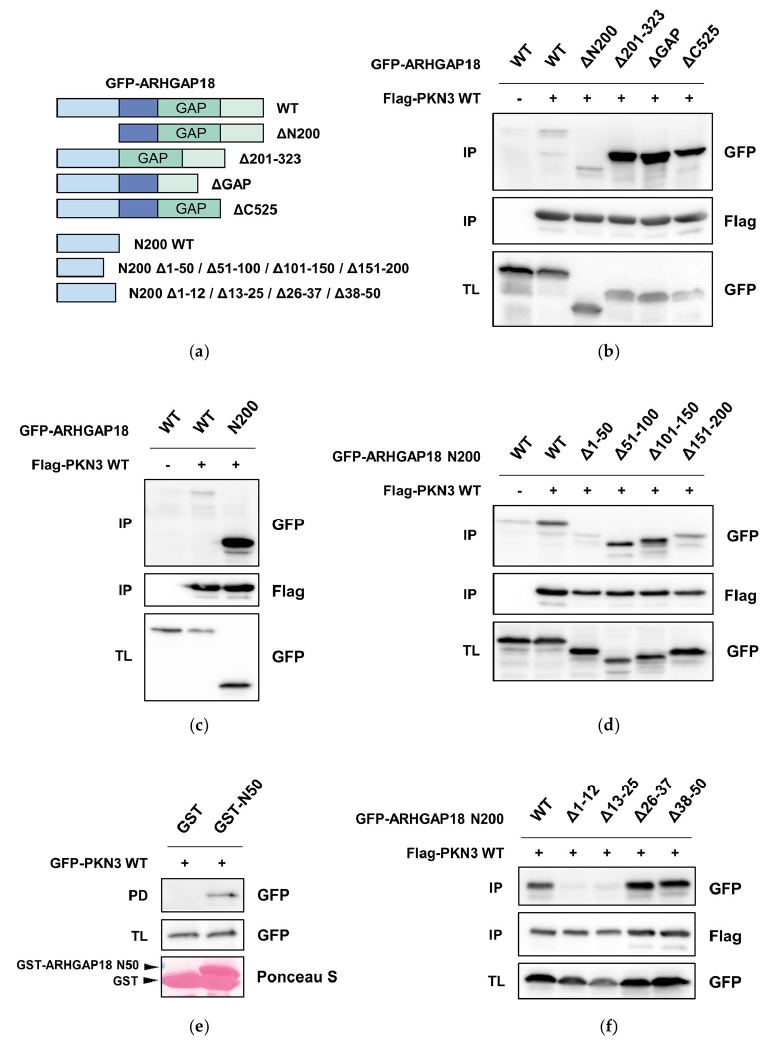
Figure 3. ARHGAP18 interacts with PKN3 ( a ) Schematic representation of ARHGAP18 mutants